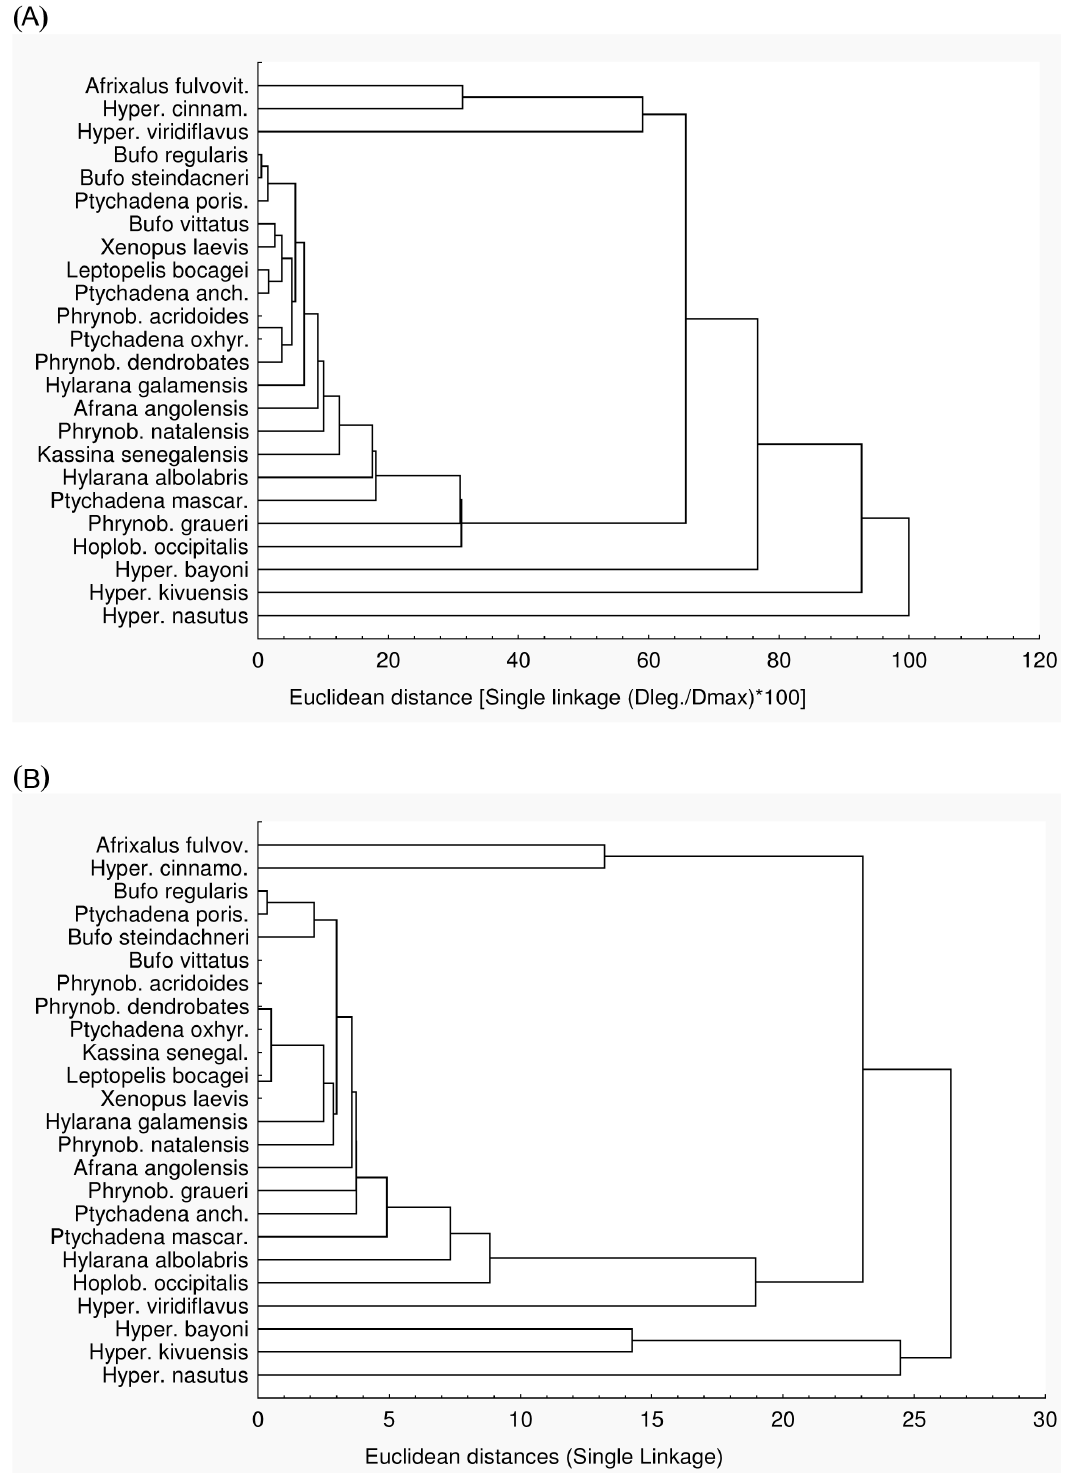
Fig. 2. UPGMA dendrogram showing the dissimilarities among amphibian species based on their presence/absence in the six habitat types, during the wet season (A) and during the dry season